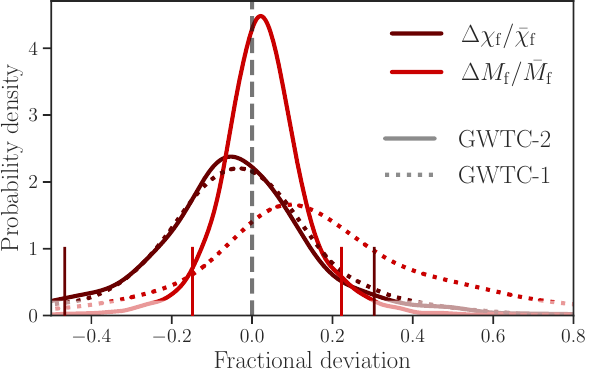
Figure 4. Posterior distributions on the mass-spin deviation parameters (black and purple curves) were obtained by hierarchically combining the events [30]. Solid lines represent GWTC-2 events, while dotted lines represent GWTC-1 events. The vertical bars represent 90% confidence